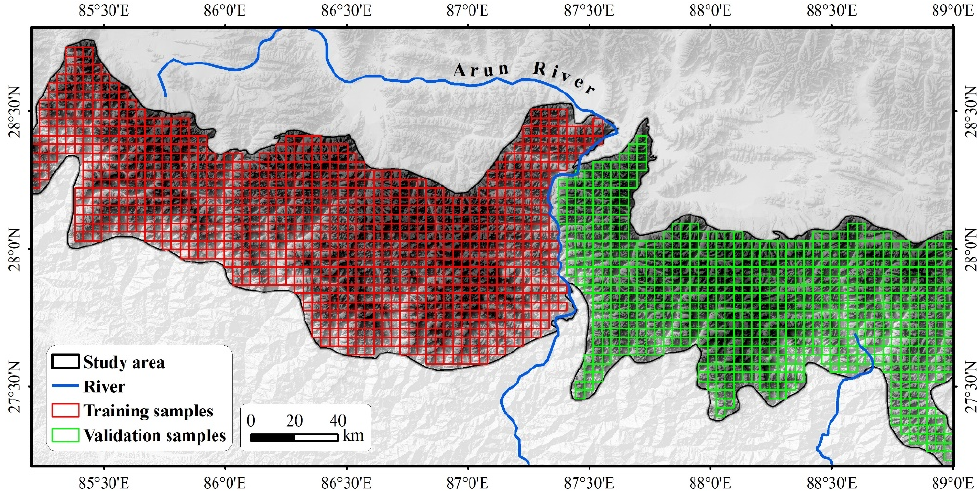
Figure 4. Flow diagram of the methods in the study.